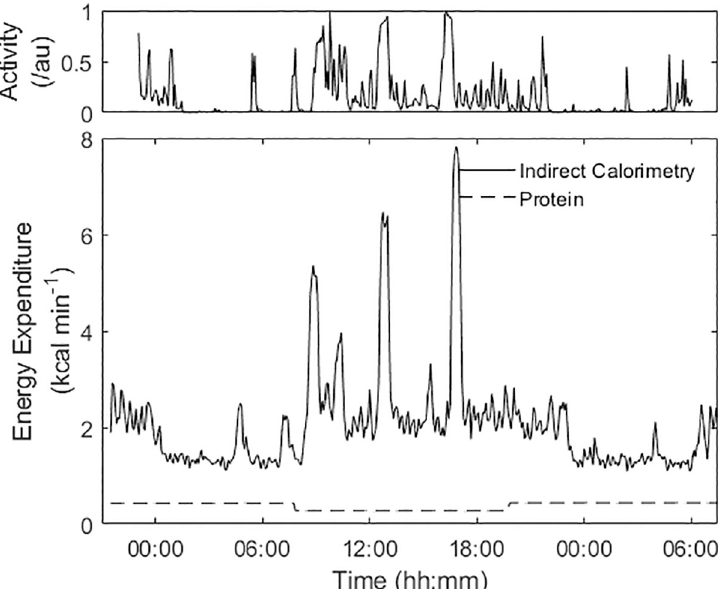
Fig 2. An example of the time history of energy expenditure during the 36-hour study period. The glucose/ glycogen energy expenditure is determined from the difference in the O2 and CO2 concentrations entering and leaving the whole body calorimeter. The protein energy is determined from the 12-hour urine sample analysis. The participant activity from the ultrasound movement sensors has been scaled 0–1 and is shown at the top of the graph.